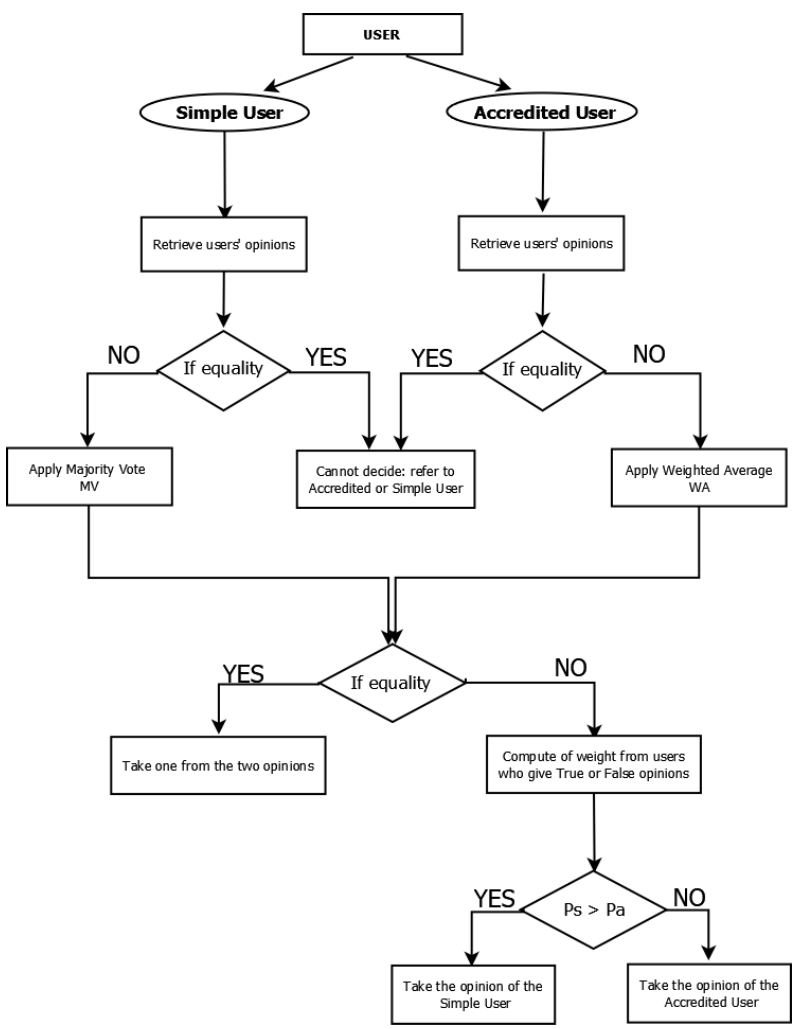
Figure 4. Flowchart of proposed